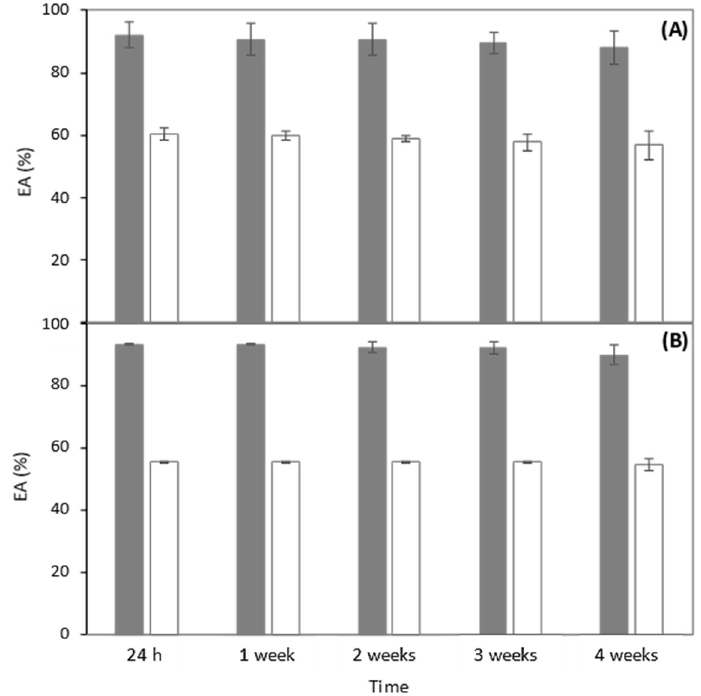
Figure 4. EA of the biosurfactant produced by B. thailandensis , at a concentration of 10 g/L, emulsified with almond oil ( A ) and sunflower oil ( B ) for 4 weeks (gray bars). The chemical surfactant Triton X-100 (white bars) was used for comparison, at the same concentration.